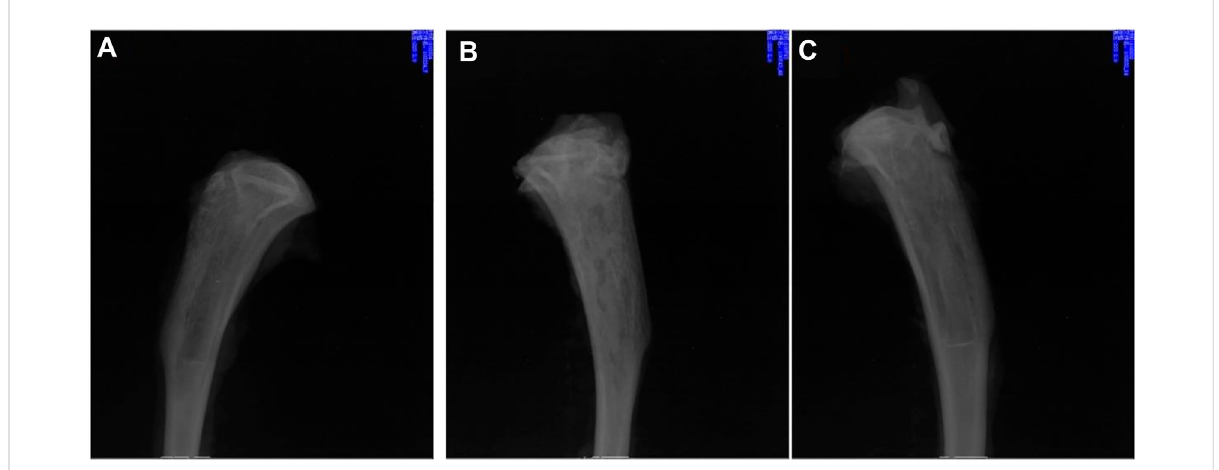
FIGURE 7 X-rays of chronic-osteomyelitis-mode. Treatment group (treated with cipro fl oxacin-loaded PTMC implants) (A) , control group (treated with PTMCimplantswithoutcipro fl oxacin) (B) ,andblankgroup(notreatment) (C) after28 daysoftreatments.ReproducedwithpermissionfromLiuetal. (2022). Copyright © 2022 The